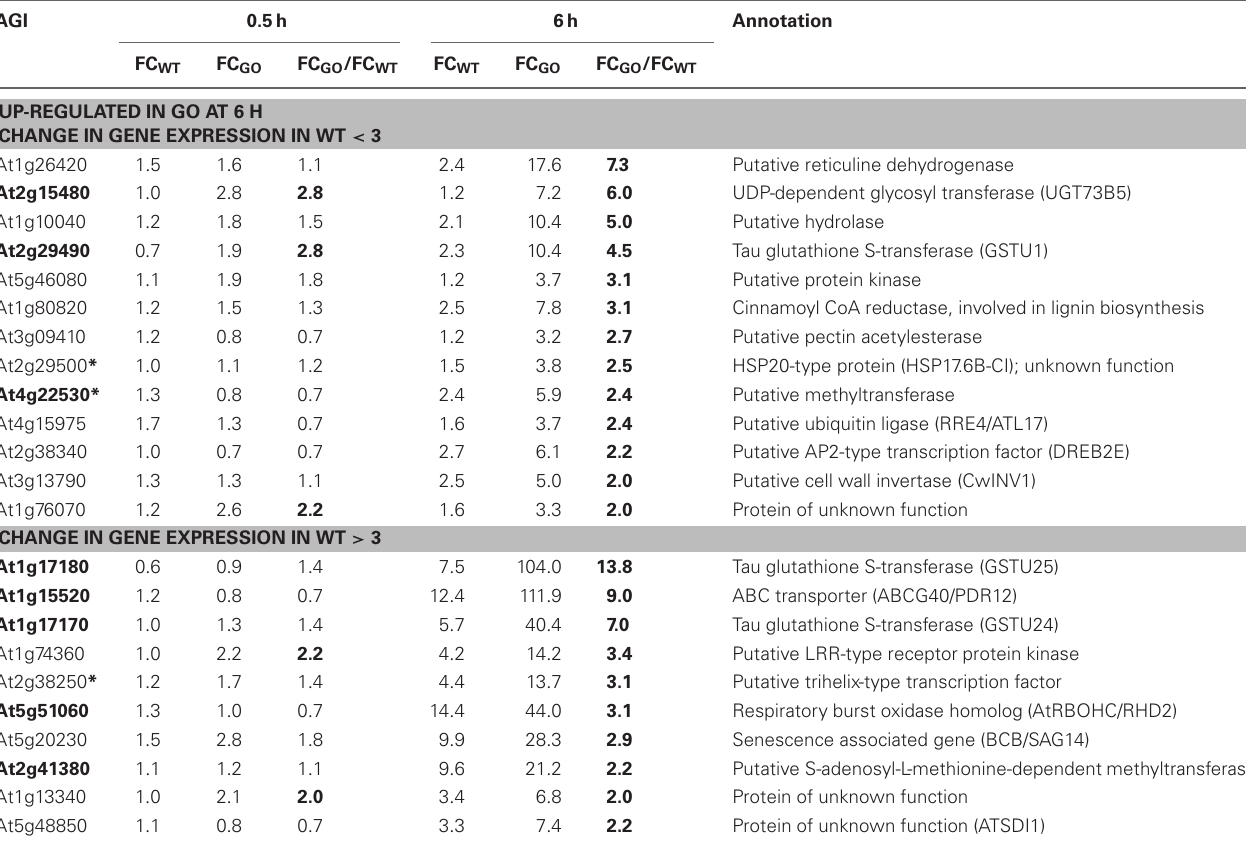
Table 3 | ROS-responsive genes (23 in total) the expression of which was enhanced more than 3-fold in GO plants 6h after shifting plants grown at high CO 2 concentration to ambient CO 2 concentration.